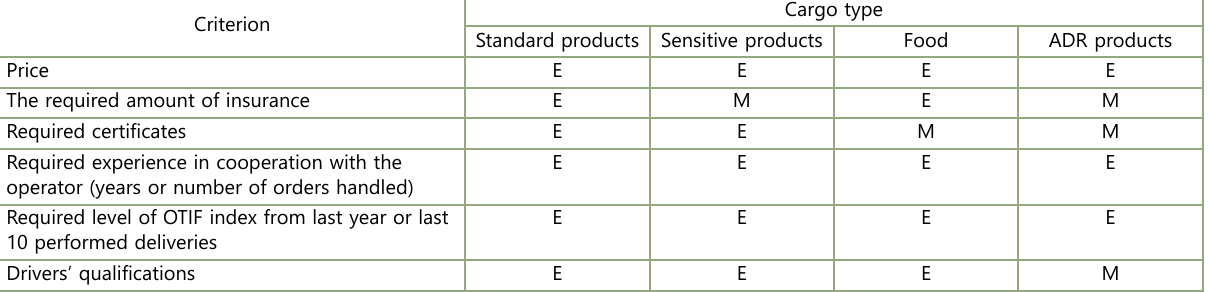
Table 2. Type of assessment parameters according to the individual product groups (source: own contribution)